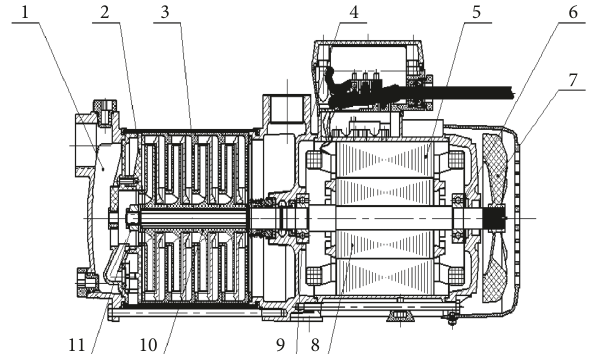
Figure 1: Assembly diagram of the cantilever multistage pump. 1, inlet cavity; 2, self-priming cavity; 3, diffuser vane; 4, outlet cavity; 5, motor stator; 6, right end bearing; 7, fan; 8, motor rotor; 9, left end bearing; 10, impeller; 11, fastening screw.